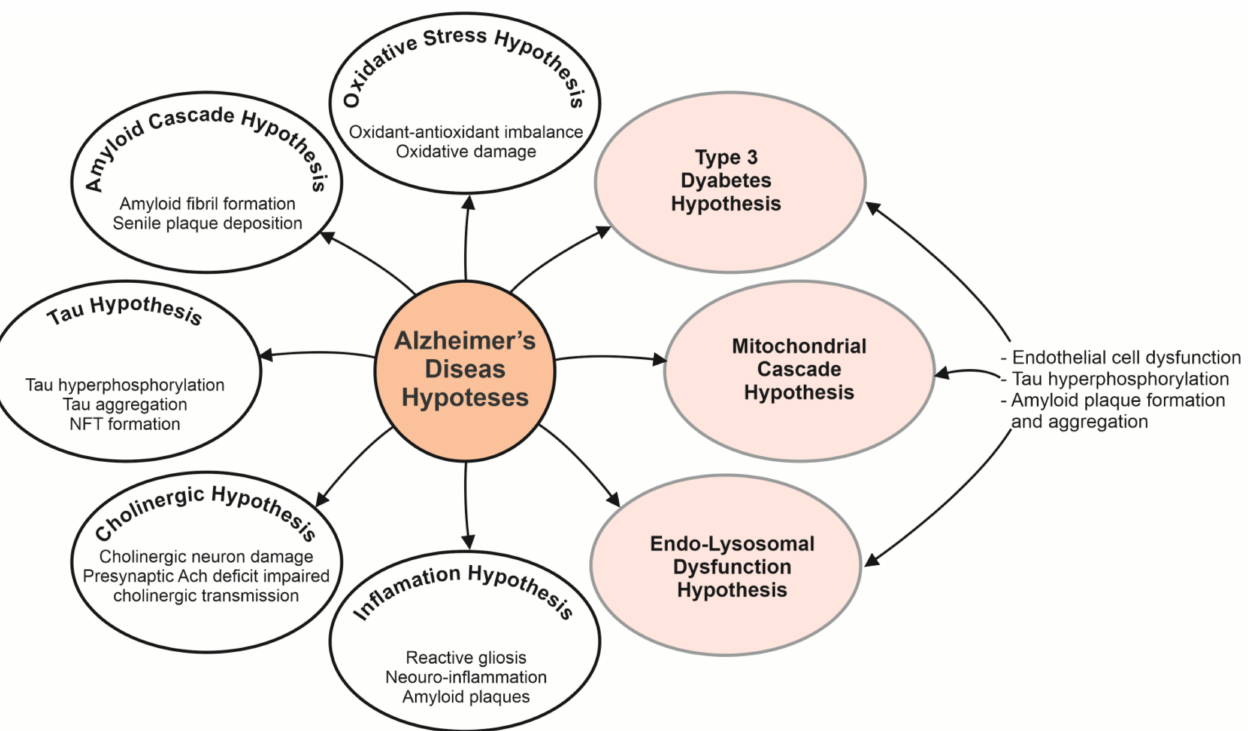
Figure 1. Alzheimer’s disease is a neurodegenerative disease that involves a multitude of factors. Given the complexity of the human brain, the lack of effective research tools and reasonable animal models, the detailed pathophysiology of the disease remains unclear. Based on multifaceted nature of AD, there have been proposed various hypotheses, including A β aggregation, cholinergic dysfunction, tau aggregation, oxidative stress, inflammation, etc. Challenges and future prospects include extensive testing of new hypotheses such as endo-lysosomal, mitochondrial and metabolic dysfunctions to attack the disease from different angles for the effective development of an early diagnosis and successful drugs for therapies. NTF, neurofibrillary tangle; Ach,